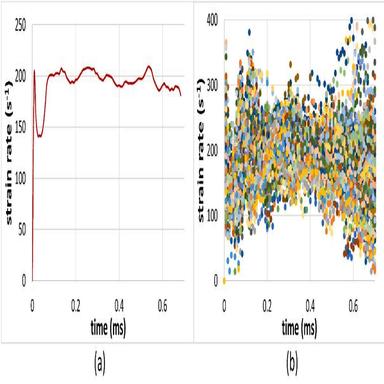
Evolution of (a) AOI-averaged strain rate and (b) strain rates at all triangular elements (strain rate distribution) in the AOI obtained from the IFHS tester.